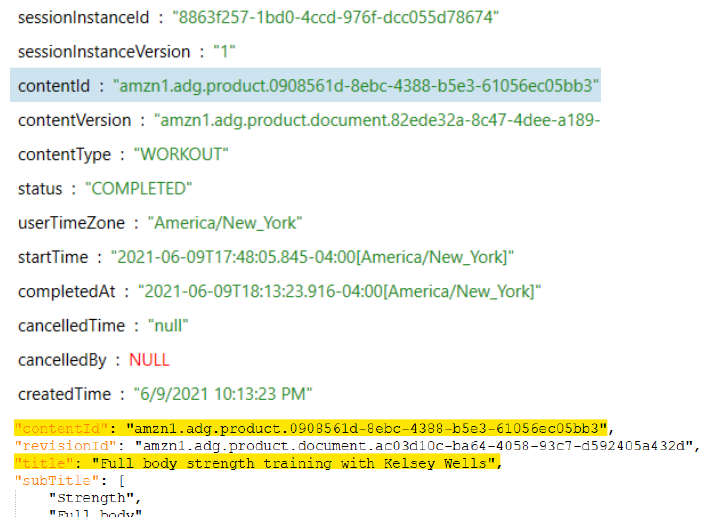
Figure 13. Record of a workout video the Amazon Halo user did ( top ) and the corresponding video title ( bottom